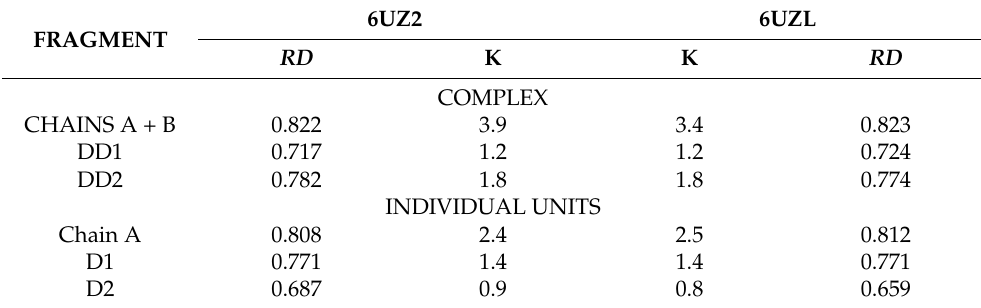
Table 3. A set of parameters that define the MsbA status for forms obtained in the environment of β -dodecylmaltoside, mimicking the membrane environment. D# means another domain treated as an individual structural unit; DD# means the status of a set of domains in a homodimer.